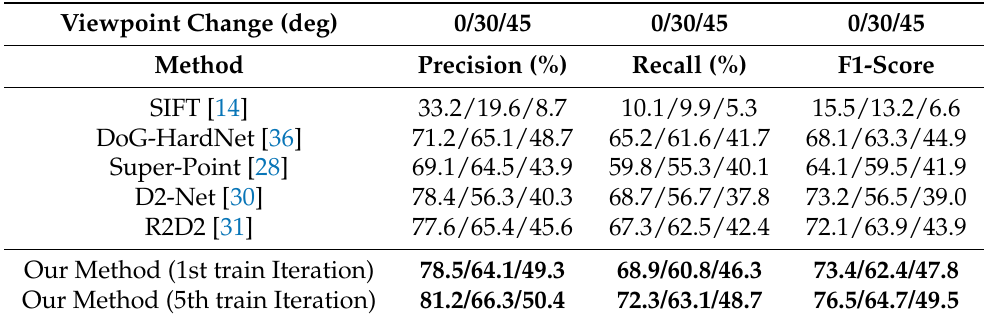
Table 3. RGB-IR image pairs matching results using 6K features. Precision (%), recall (%), and F1-score at different viewpoint change thresholds are reported.